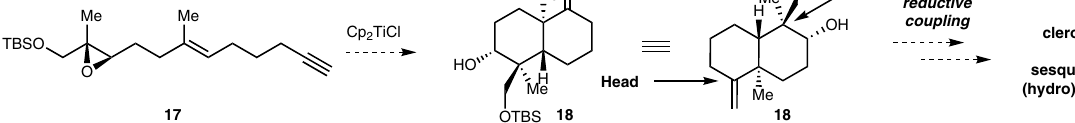
Fig. 1 | Selected trans -clerodanes and sesquiterpene (hydo)quinones, the hypothesis of the biogenesis of such structures and our synthetic strategies. a Selected trans -clerodanes and sesquiterpene (hydo)quinones that feature the similar trans -decalincorestructure 1 or ent - 1 . b Nature ’ shead-to-tailcyclizationand